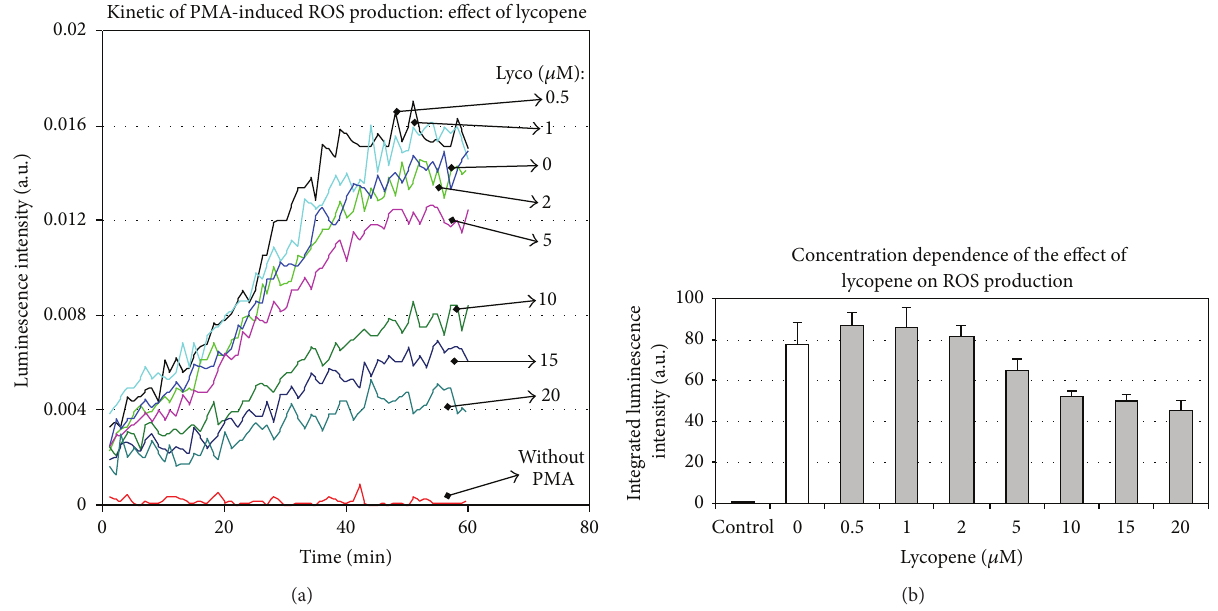
Figure 4: Lycopene modulates PMA-induced ROS production in THP1 cells. THP1 cell suspension was distributed into multiwell plates and, according to the assays, different concentrations of lycopene were added for 2 hours. Then, PMA (100nM) together with lucigenin was added, and ROS-induced luminescence was immediately recorded for 60 min (a). Data were collected on computer and kinetics integration was performed (b). A representative experiment is shown. Values are means ± SD ( 𝑛 = 8